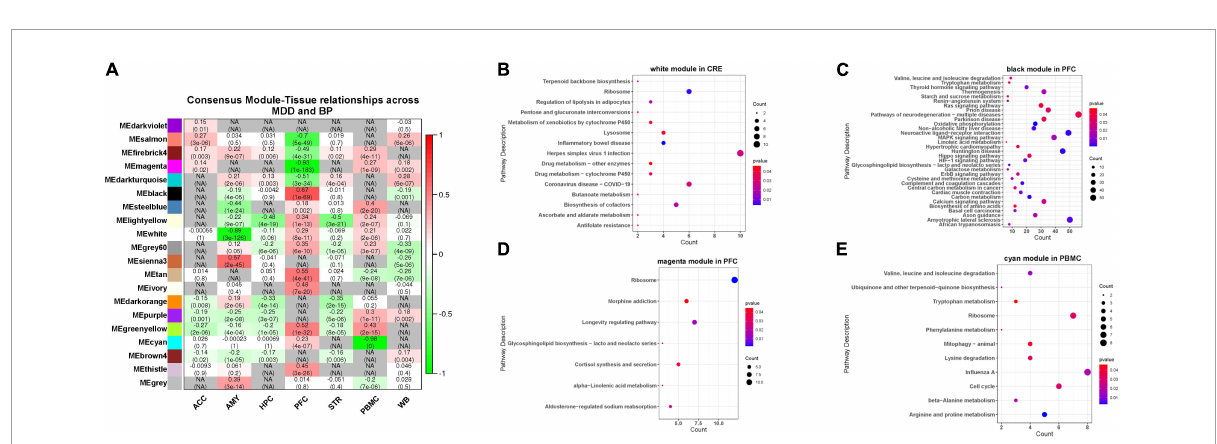
FIGURE4 (A) Correlation between MDD-BP co-expression network and tissue. Here, the smaller absolute correlation coefficients and p -value between MDD- and BP- was shown, while N/A represents for inconsistent modules. (B–E) We focus on the modules with the consistency of positive and negative correlations in the two diseases, here we showed functional analysis of consistent modules, including CRE (white modules), PFC (black and magenta modules), and PBMC (cyan